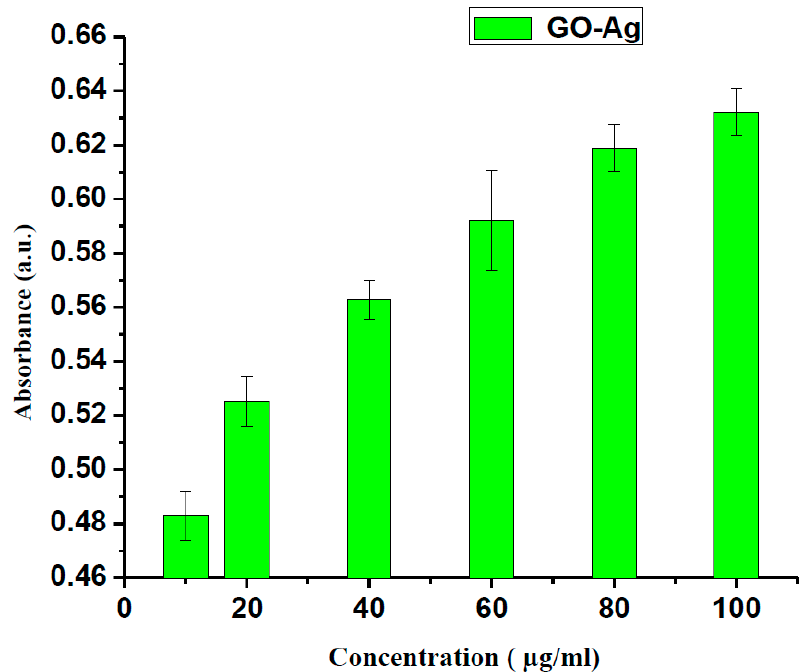
Figure 5. Absorbance versus concentration of GO-Ag nanocomposites.